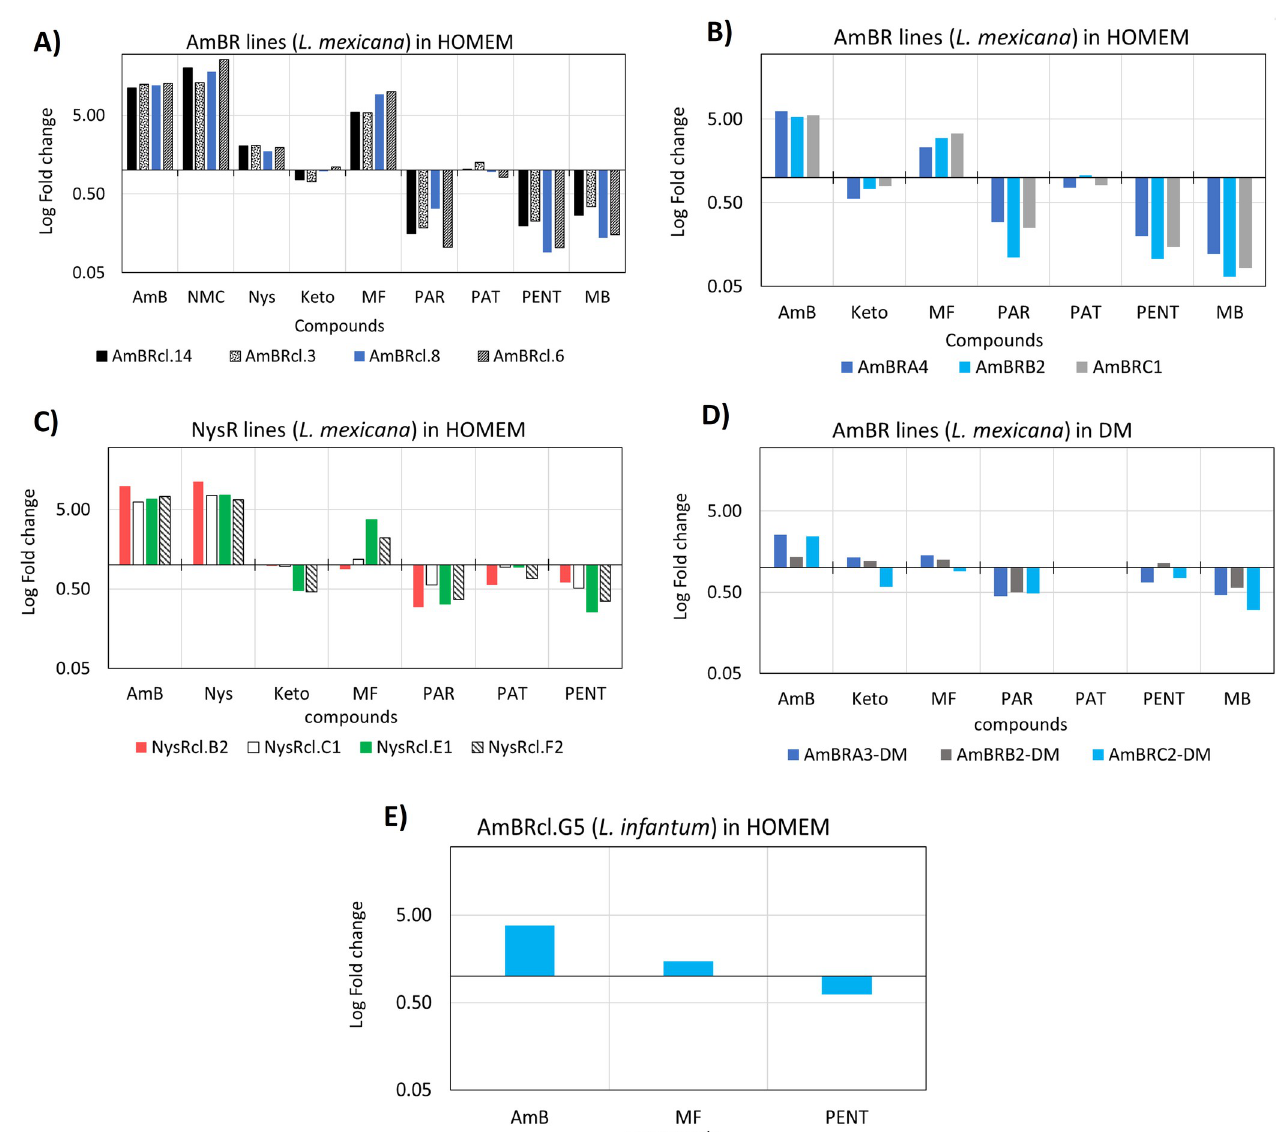
Fig 1. Fold change in EC 50 in all polyene resistant lines of Leishmania spp . Log Fold change (EC 50 ) in resistant lines is relative to the respective parental wild type cultured in parallel without drug. Fig 1A and 1B) AmBR- L . mexicana in HOMEM, Fig 1C) NysR- L . mexicana in HOMEM, Fig 1D) AmBR- L . mexicana in DM and E) AmBR- L . infantum in HOMEM. Values higher and lower than 1, indicate a decrease and rise in susceptibility relative to the parental line, respectively. A complete list of values in fold-change and EC 50 with statistical analysis is provided in S3 Table. AmB (amphotericin B), Nys (nystatin),